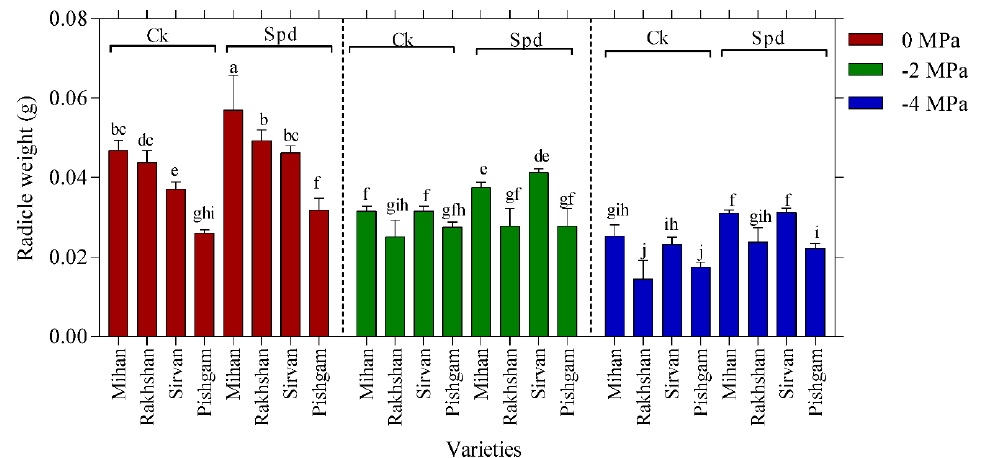
Figure 2. Effect of spermidine (Spd) on radicle weight of four wheat varieties under drought stress with three levels of PEG 6000 osmotic potential (−2, −4 MPa and 0 using distilled water as control). Ck = distilled water. Different letters indicate statistically significant differences across all three levels of PEG 6000 at p < 0.05 level using LSD’s test.